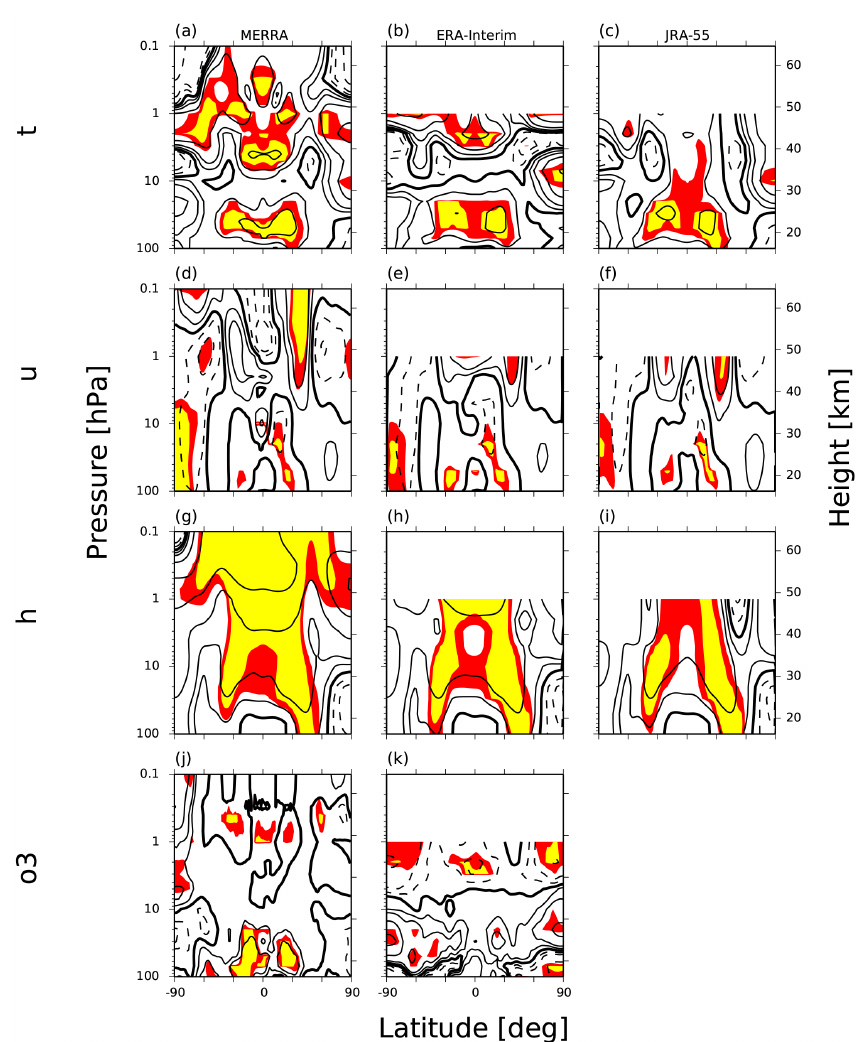
Figure 1. The annually averaged response of the solar signal in the MERRA, ERA-Interim and JRA-55 zonal-mean temperature t (a–c) , unit: K, contour levels: 0, ± 0 . 25, ± 0 . 5, ± 1, ± 2, ± 5, ± 10, ± 15, ± 30; zonal wind u (d–f) , unit: ms − 1 , contour levels: 0, ± 1, ± 2, ± 5, ± 10, ± 15, ± 30; geopotential height h (g–i) , unit: gpm, contour levels: 0, ± 10, ± 20, ± 50, ± 100, ± 150; and ozone mixing ratio o 3 (j–k) , unit: percentage change per annual mean, contour levels: 0, ± 1, ± 2, ± 5, ± 10. The response is expressed as a regression coefficient RC (corresponding units per S max minus S min ). The statistical significance of the scalar fields was computed by a t test. Red and yellow areas indicate p values < 0.05 and